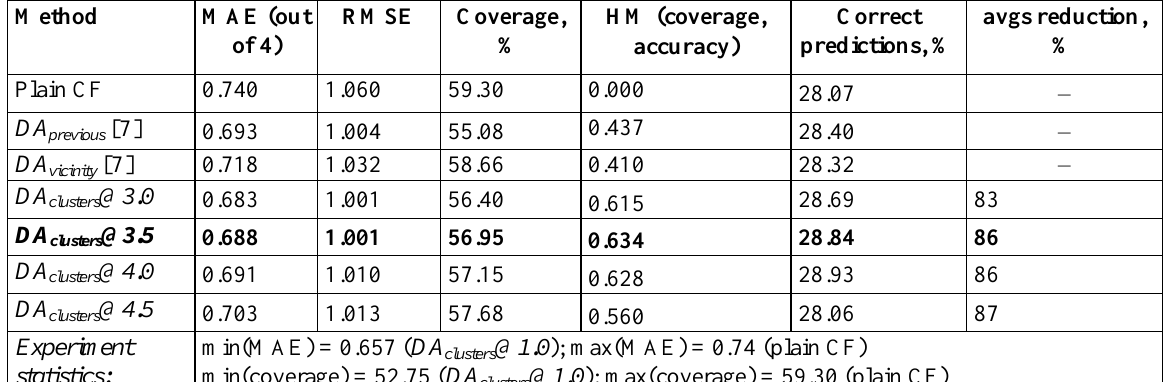
Table 3. Amazon “CDs and Vinyl” dataset